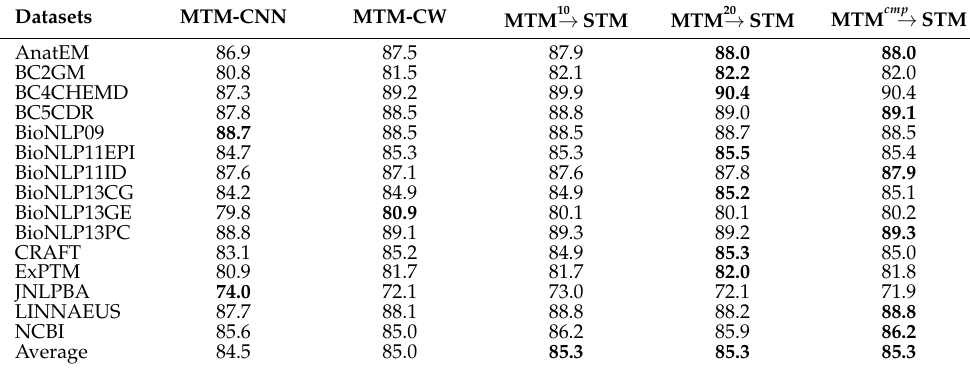
Table 7. Results comparison of MTM → STM with state-of-the-art MTMs.